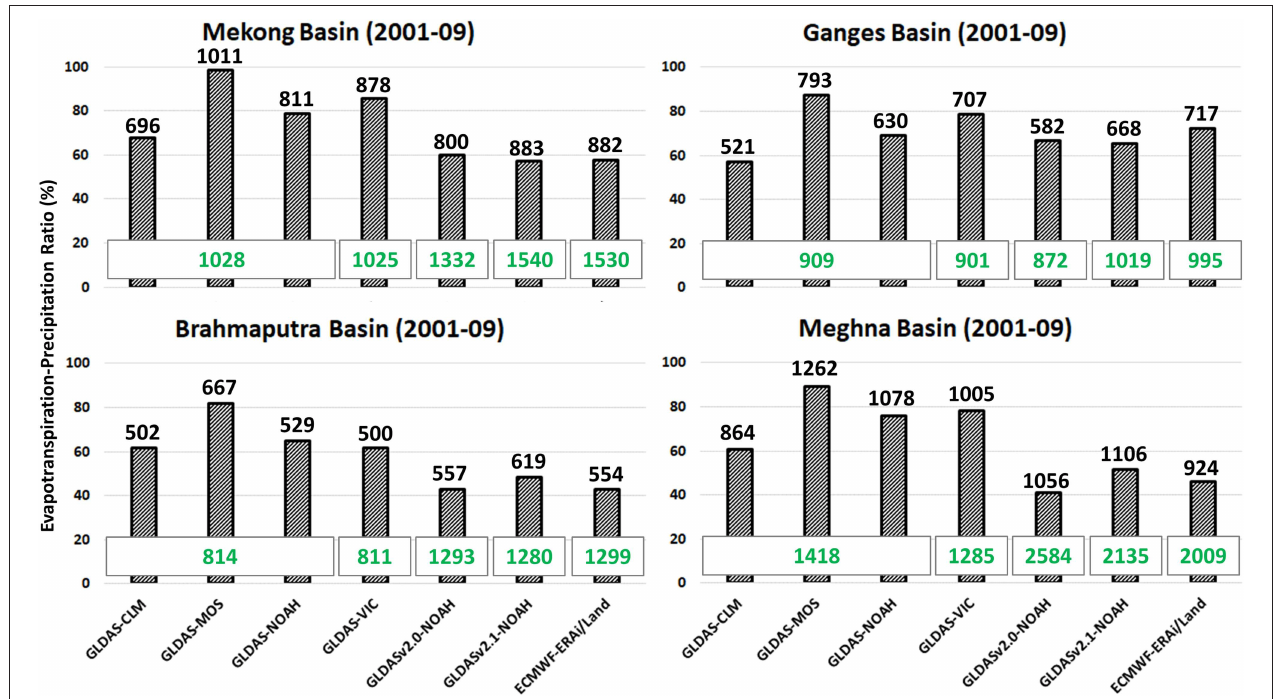
FIGURE 2 | Mean annual Evapotranspiration-Precipitation ratio the Mekong and GBM basins. All the values shown above the bars and in the boxes are the simulated mean annual evapotranspiration and input precipitation in mm, respectively.